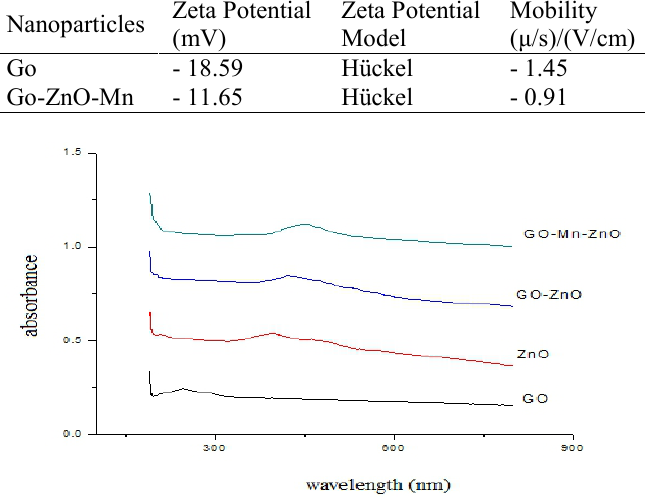
Table 2. Zeta Potential of Nanoparticles Zeta Potential Zeta Potential Nanoparticles Model